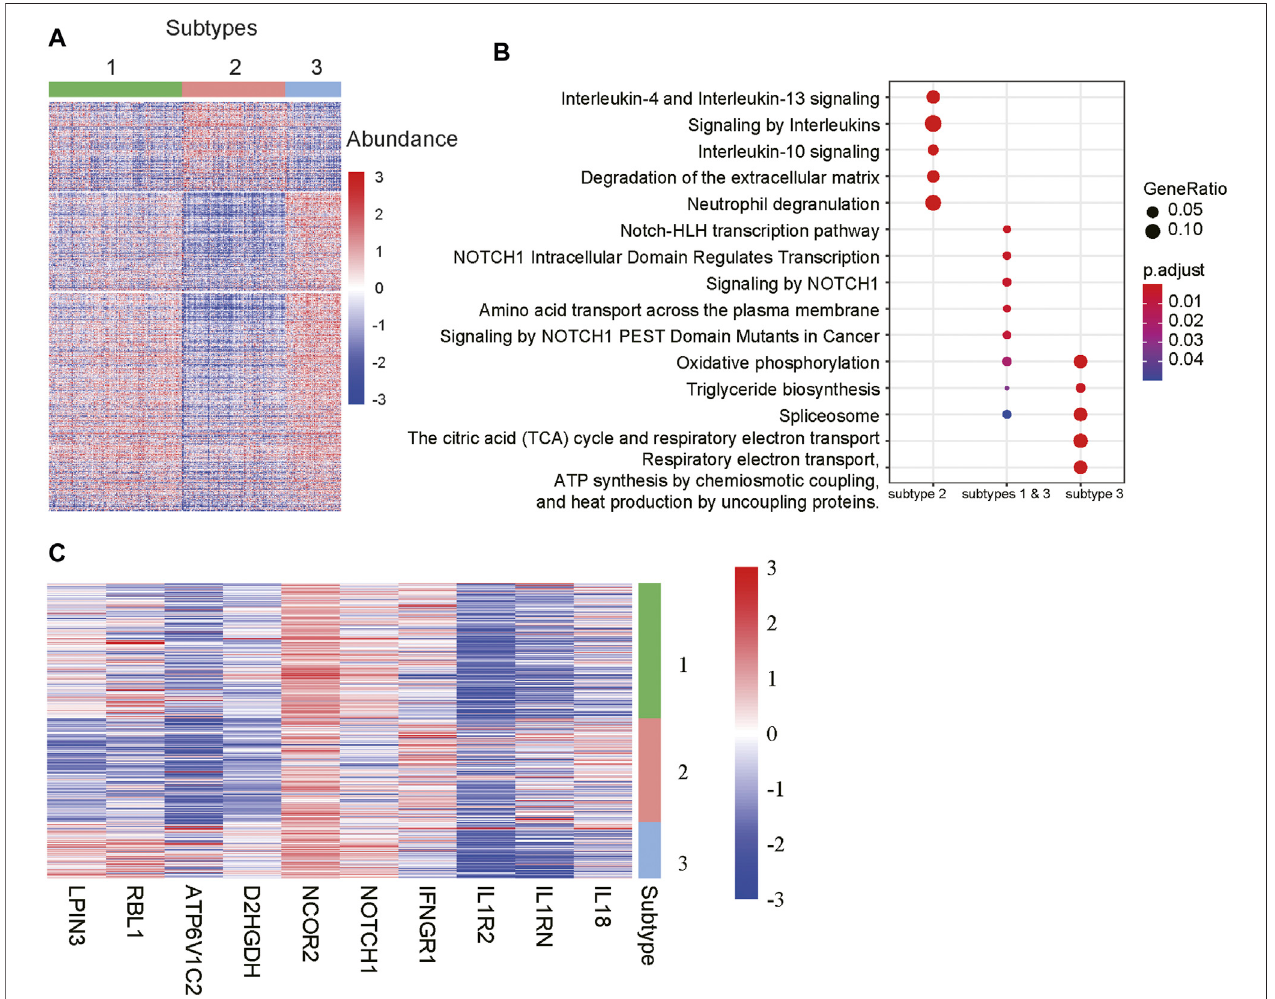
FIGURE4| Differentiallyexpressedgenesandpathwaysamongthesubtypes. (A) Thegeneexpressionpro fi lesofthedifferentiallyexpressedgenes(DEGs)among the subtypes. The colors on the top represent the subtypes. The red and blue colors in the heatmap indicate high and low expression, respectively. (B) The signaling pathwaysenrichedbytheDEGs.Thex-labelssuchassubtype2,subtype1&3,andsubtype3representthepathwaysenrichedbytheDEGsupregulatedinsubtypes2, both 1 and 3, and 3, respectively. (C) The representative genes differentially expressed in the subtypes.